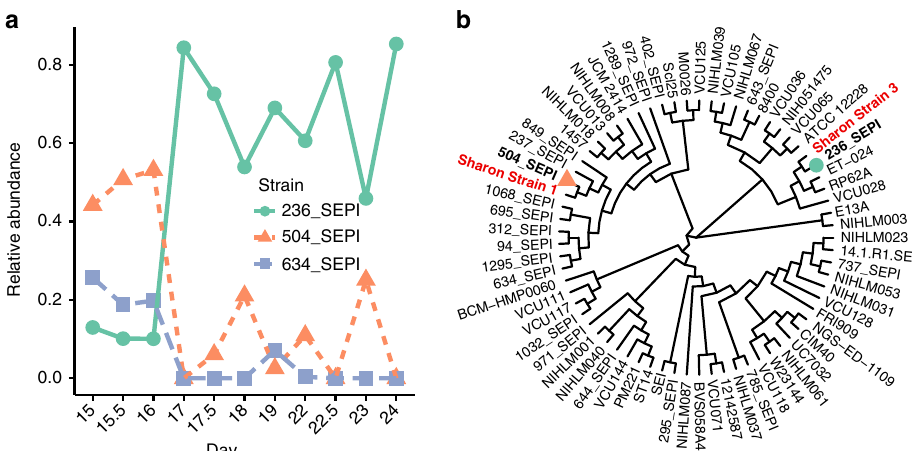
Fig. 7 S. epidermidis strains in early stages of an infant gut colonization. a Three coexisting strains were found, with shifting relative abundances. While the three initial samples were dominated by strain 504_SEPI, at later times, strain 236_SEPI was the most abundant. b Whole-genome cladogram of the reference genomes, also including the two high-quality genome sequences (Sharon strain 1 and Sharon strain 3) assembled in the original paper from the same samples. These genomes are closely related to the two strains identi fi ed by